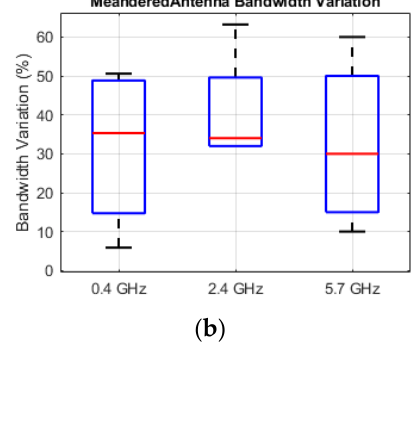
Table 2. SAR in one gram of tissue by 1 W stimulation.